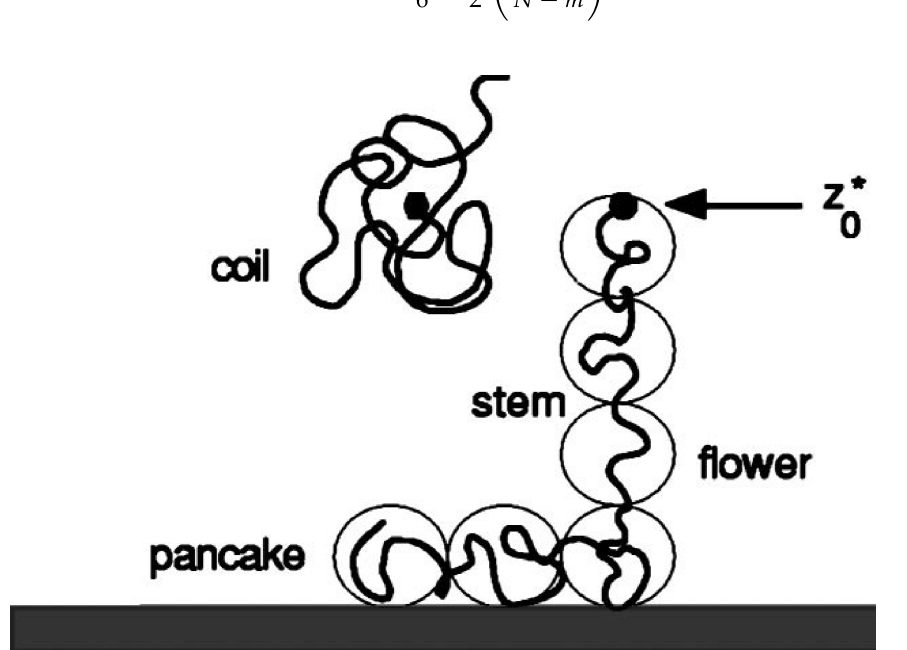
Figure 1. Illustration of the coil-to-flower transition for an adsorbed chain pulled by one end away from an adsorbing surface. The flower is composed of m adsorbed segments (pancake) and N − m stretched segments (stem). The spheres are illustrative for the respective blobs, near the surface they have the size ξ a = 1/ c ( c is the de Gennes adsorption parameter, and in the tether ξ s = 1/ f ( f is the pulling force). z 0 is the position of the end of the chain. At the first-order transition the position is denoted by z ∗ . At that point the number of adsorption blobs equals the number of stretching blobs and 0 the free energy of the coil equals that of the